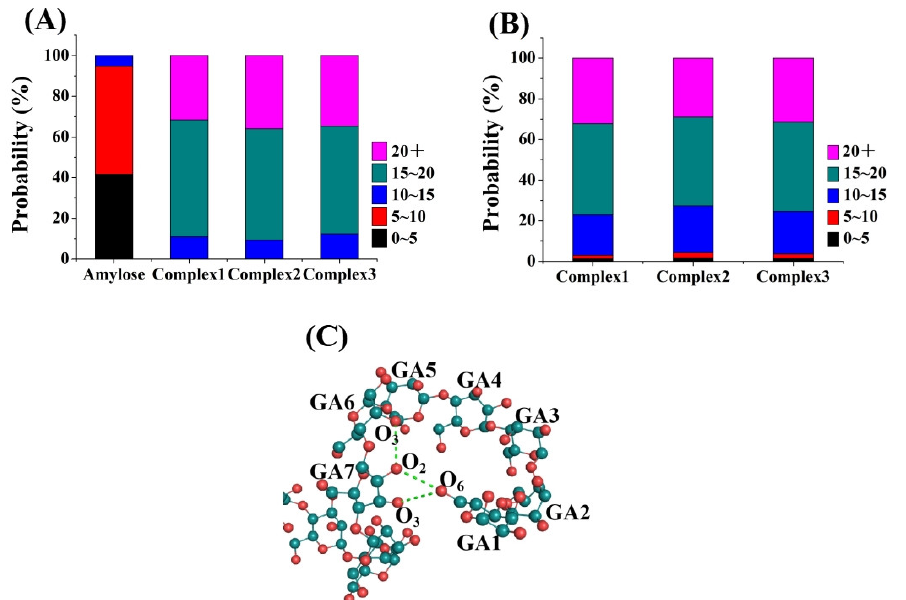
Figure 2. ( A ) Percentages of intramolecular hydrogen bonds number of amylose molecule in single- strand system and three amylose–zein complexes with different initial values (the number of intra- molecular hydrogen bonds are shown in the figure legend); ( B ) Percentages of intermolecular hydrogen bonds number between amylose molecule and zein molecule in three amylose–zein com- plexes with different initial values (the number of intermolecular hydrogen bonds are shown in the figure legend); ( C ) O 2 -O 3 single bond between two adjacent glucose residues (GR) and O 6 -O 2 /O 3 single bond between residue x and residue x+6.